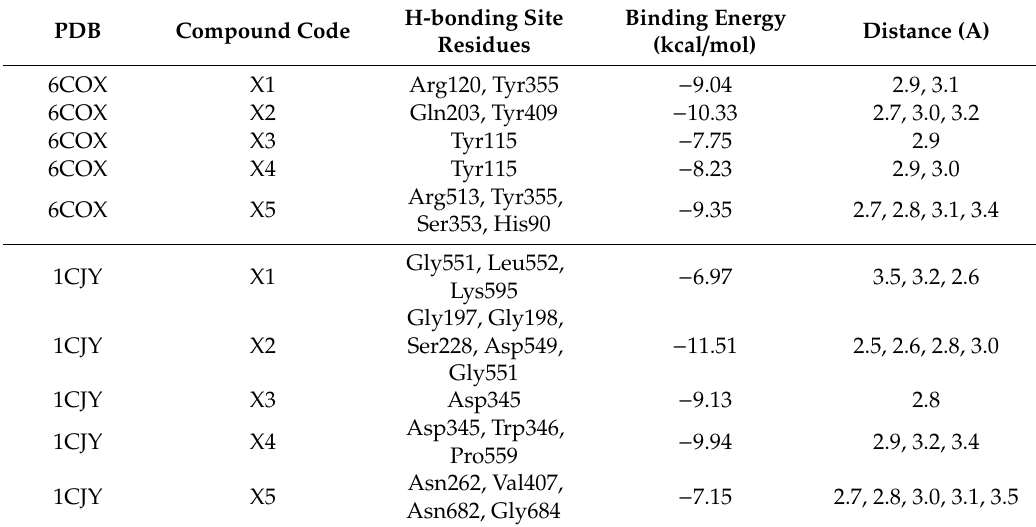
Table 4. Binding energy and interacting residues of X1 – X5 for COX-2 and cPLA 2